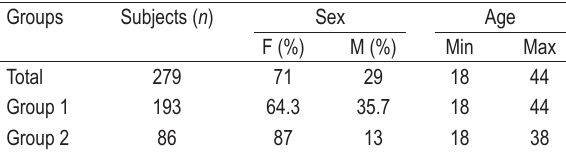
TABLE 1. Distribution of subjects’ number, sex, and age into two subjected groups